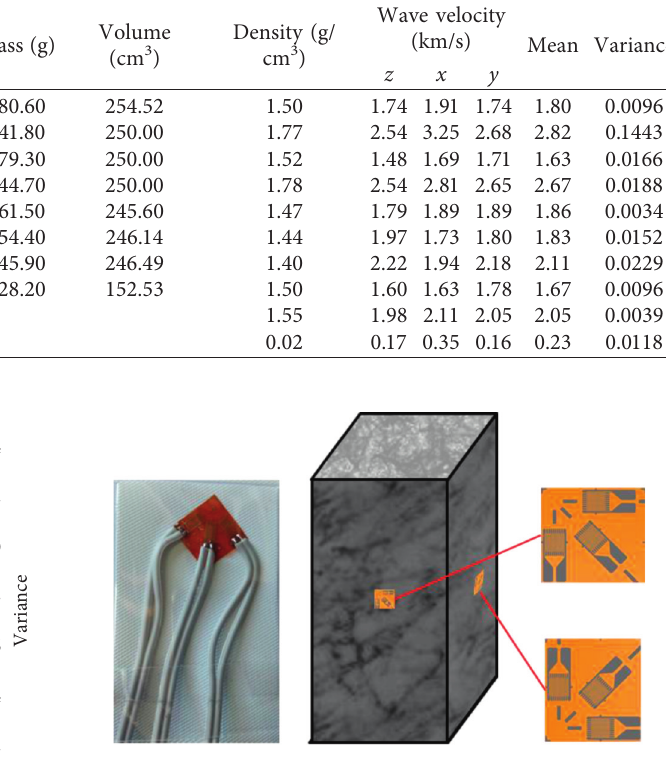
Figure 5: BX120-3CA strain gauge and its paste method.